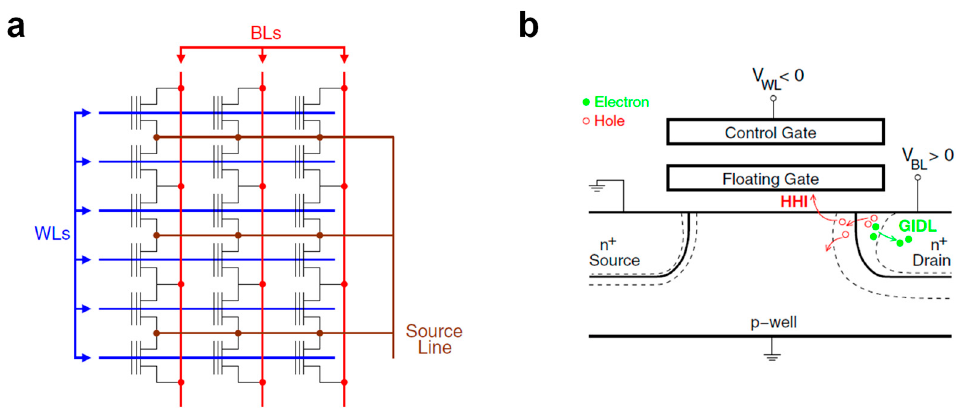
Figure 9. ( a ) Schematic for a mainstream common-ground NOR Flash array and ( b ) proposed physical mechanism exploited for the erase operations. Reprinted with permission from [57]. Copyright 2018, IEEE.